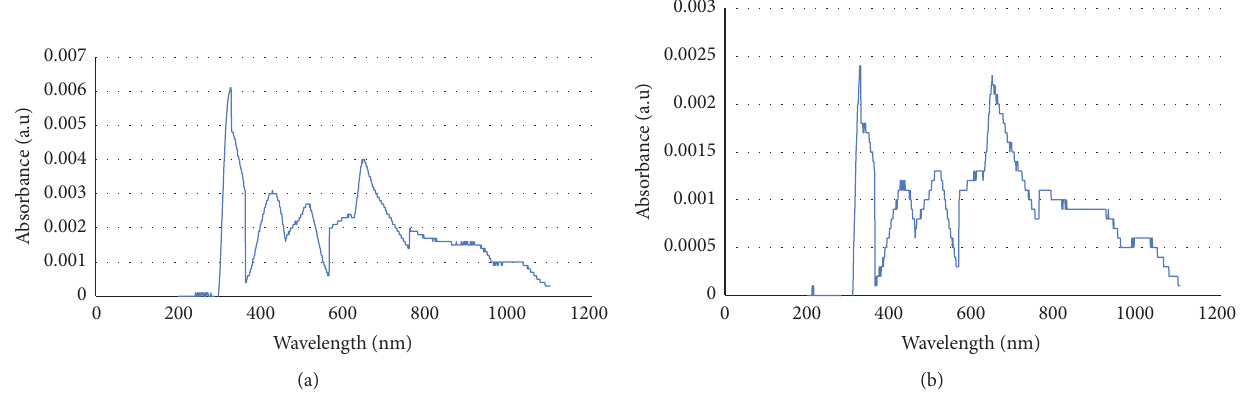
Figure 12: UV-VIS absorption spectra of silicon nanoparticles solution prepared by 200 pulses and energy of (a) 700 mJ and (b) 760